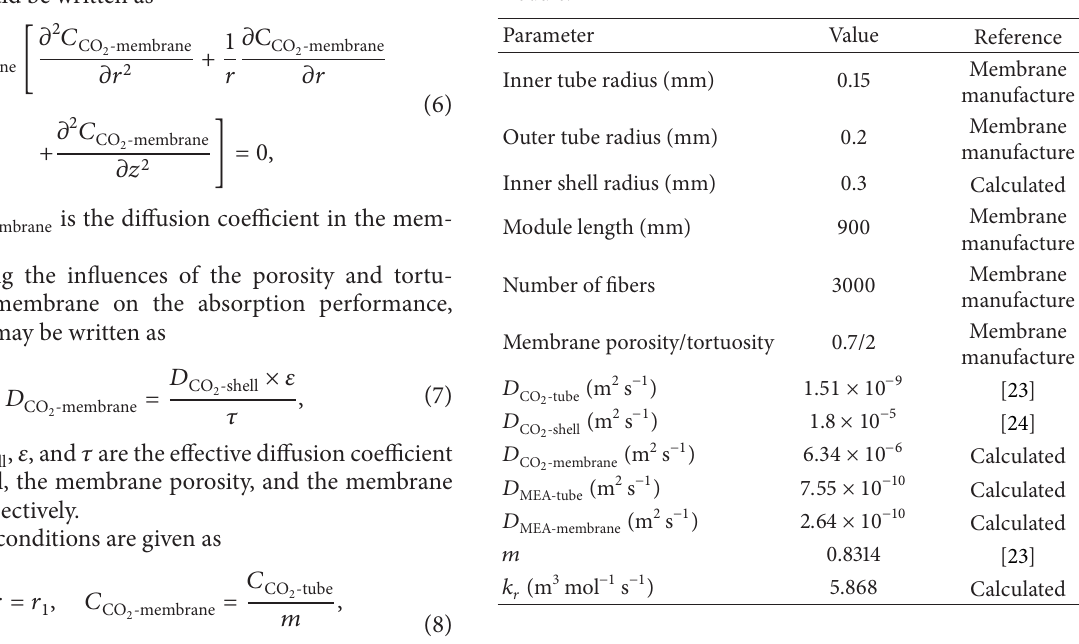
Table 1: Dimensions and properties of the membrane contactor